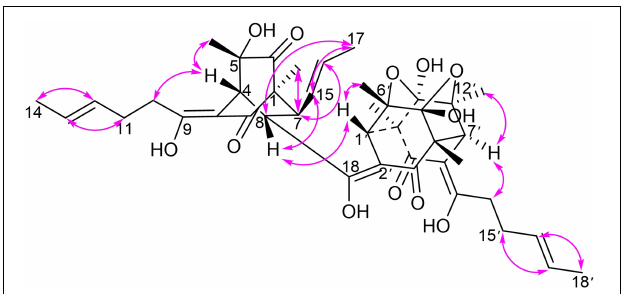
FIGURE 3 | Key NOESY correlations of compound 1 .